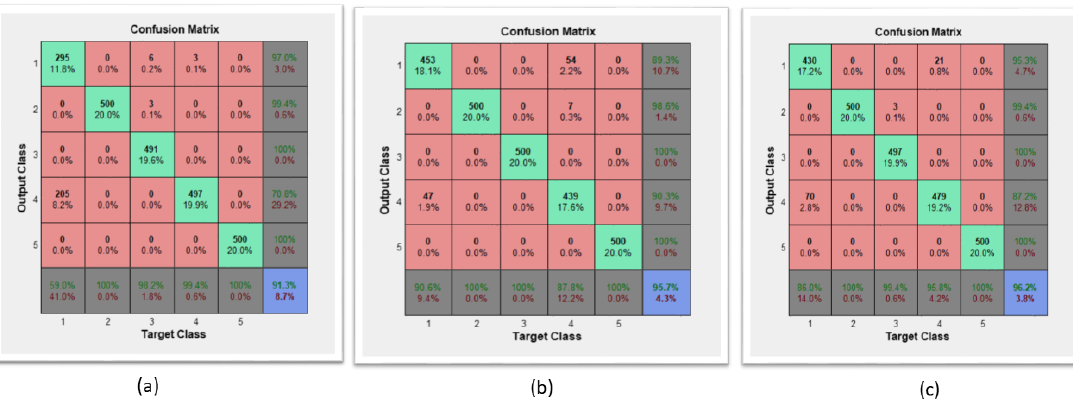
Figure 6. Comparative Analysis of Observation sets for SVM module 1 ( a – c ) to SVM module